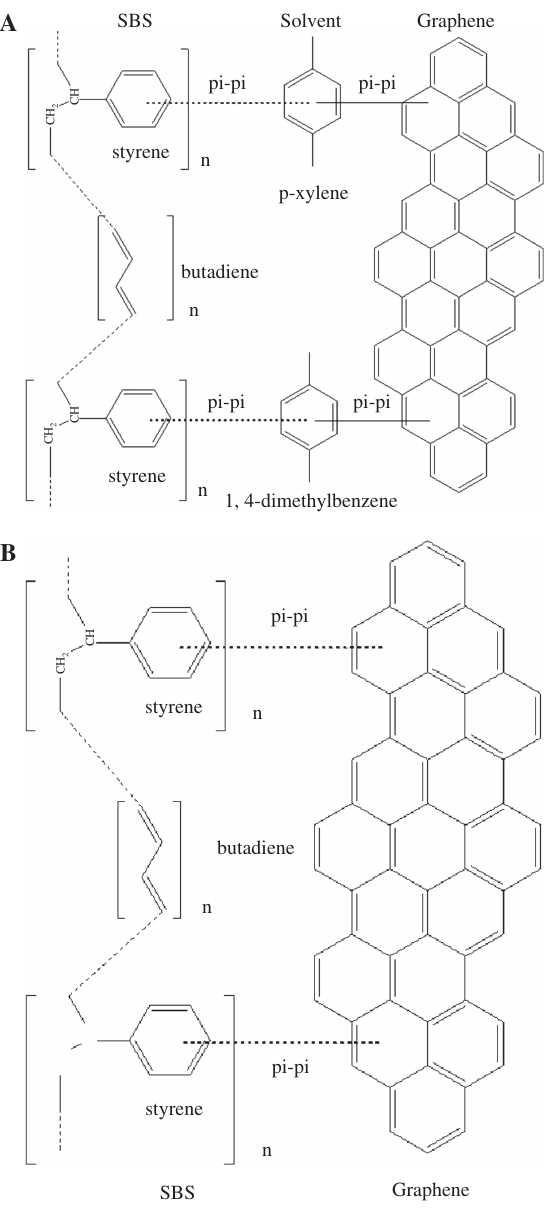
Figure 1 (A) SBS dissolved in xylene with graphene in dispersion using π - π interactions and (B) SBS-graphene π - π interaction that kept graphene dispersed